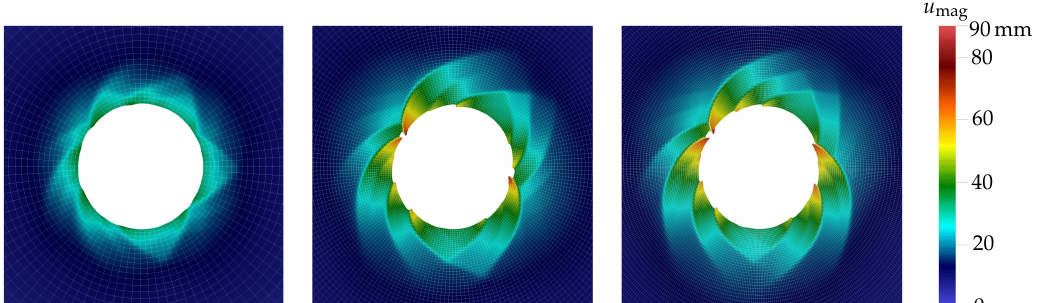
Figure 15. Distribution of the magnitude of the displacement vector in the vicinity of the tunnel surface at the level of 12% of the initial internal pressure with a displacement scale factor of 10 for the three finite element meshes with full numerical integration: coarse ( left ), medium ( center ), and fine ( right ).